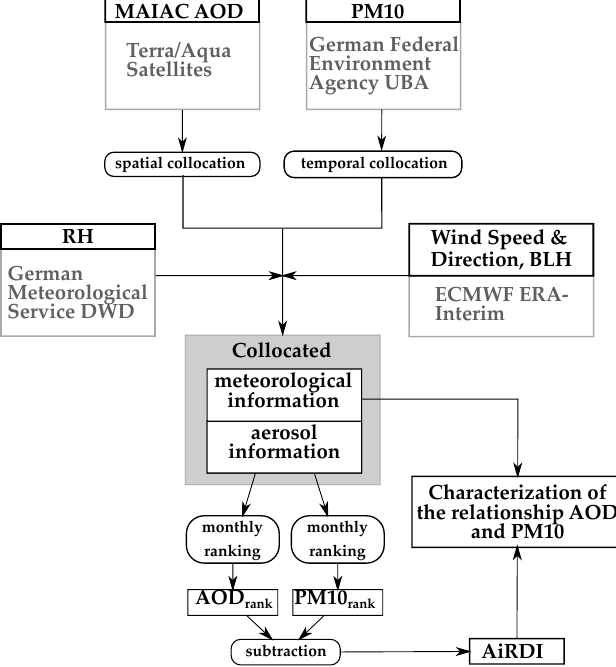
Figure 2. Overview of the work flow of this study. Methods are shown in curved boxes, inputs and outputs in rectangular